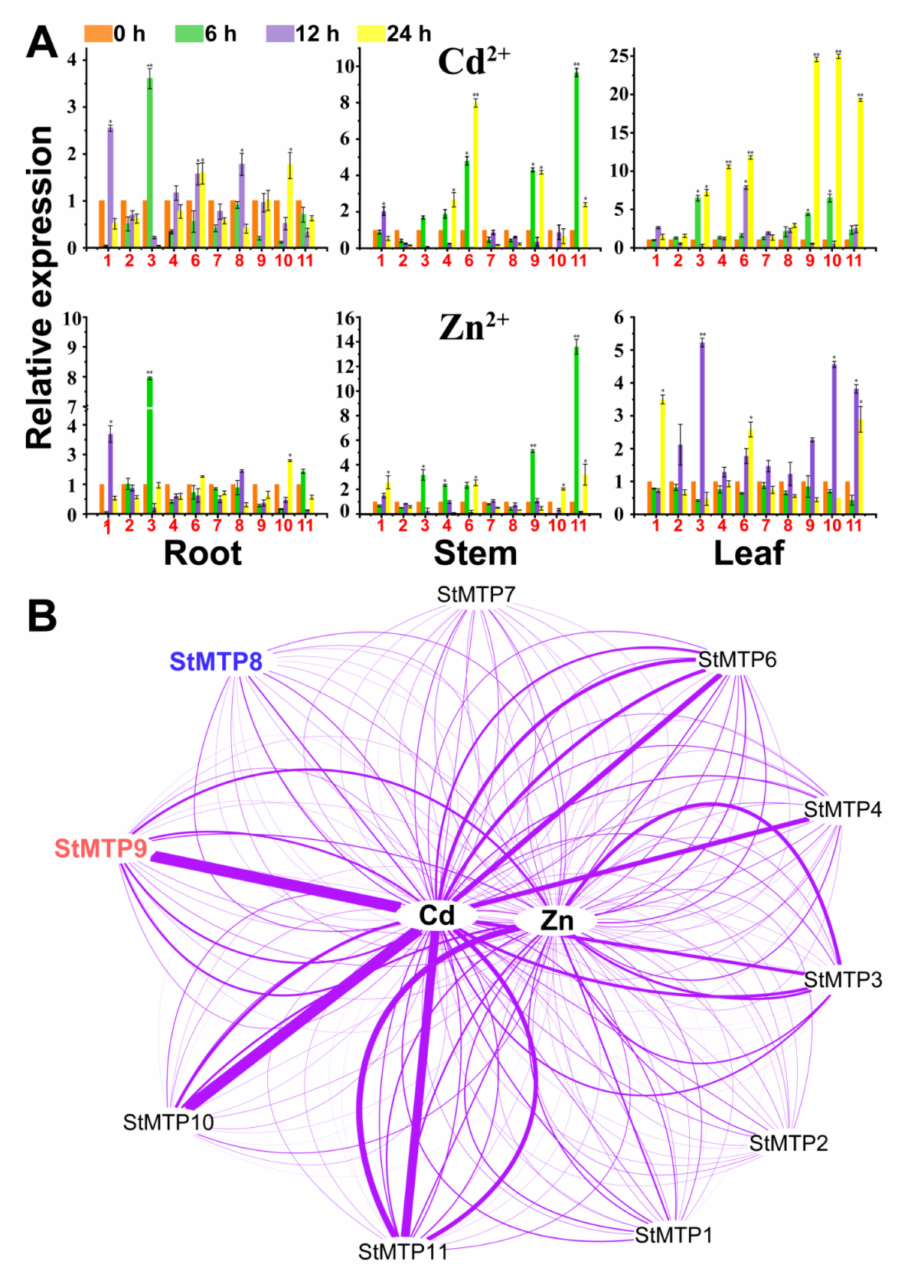
Figure 7. The expression analysis of StMTP s under Zn and Cd stress. ( A ): The expression profile of StMTPs in root, steam and leaf. The StMTPs 1–11 were abbreviated as red font 1–11. * = p ≤ 0.05, ** = p ≤ 0.01. ( B ): A visual analysis network for the influence of heavy metals on StMTP s expression. The wider connection lines between the metal and the gene, the higher expressions of the gene under the metal stress conditions. StMTP8 marked in blue and StMTP9 were marked in red font were used for subsequent heterologous expression in